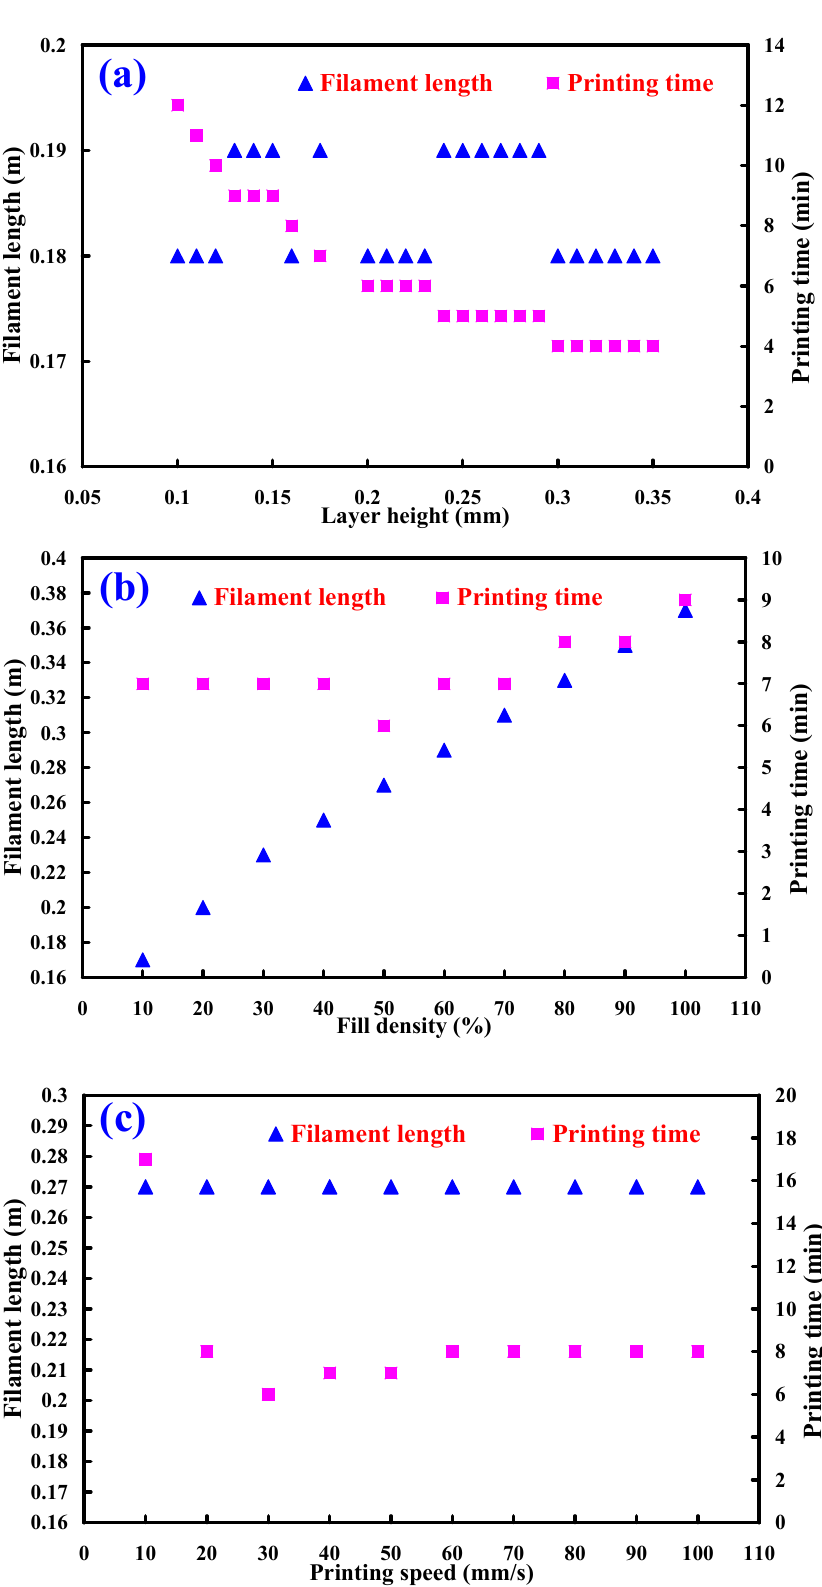
Figure 13. Filament length and printing time as a function of different ( a ) layer heights, ( b ) fill densities, and ( c ) printing speeds. Table 6. Process parameters for making physical prototype.